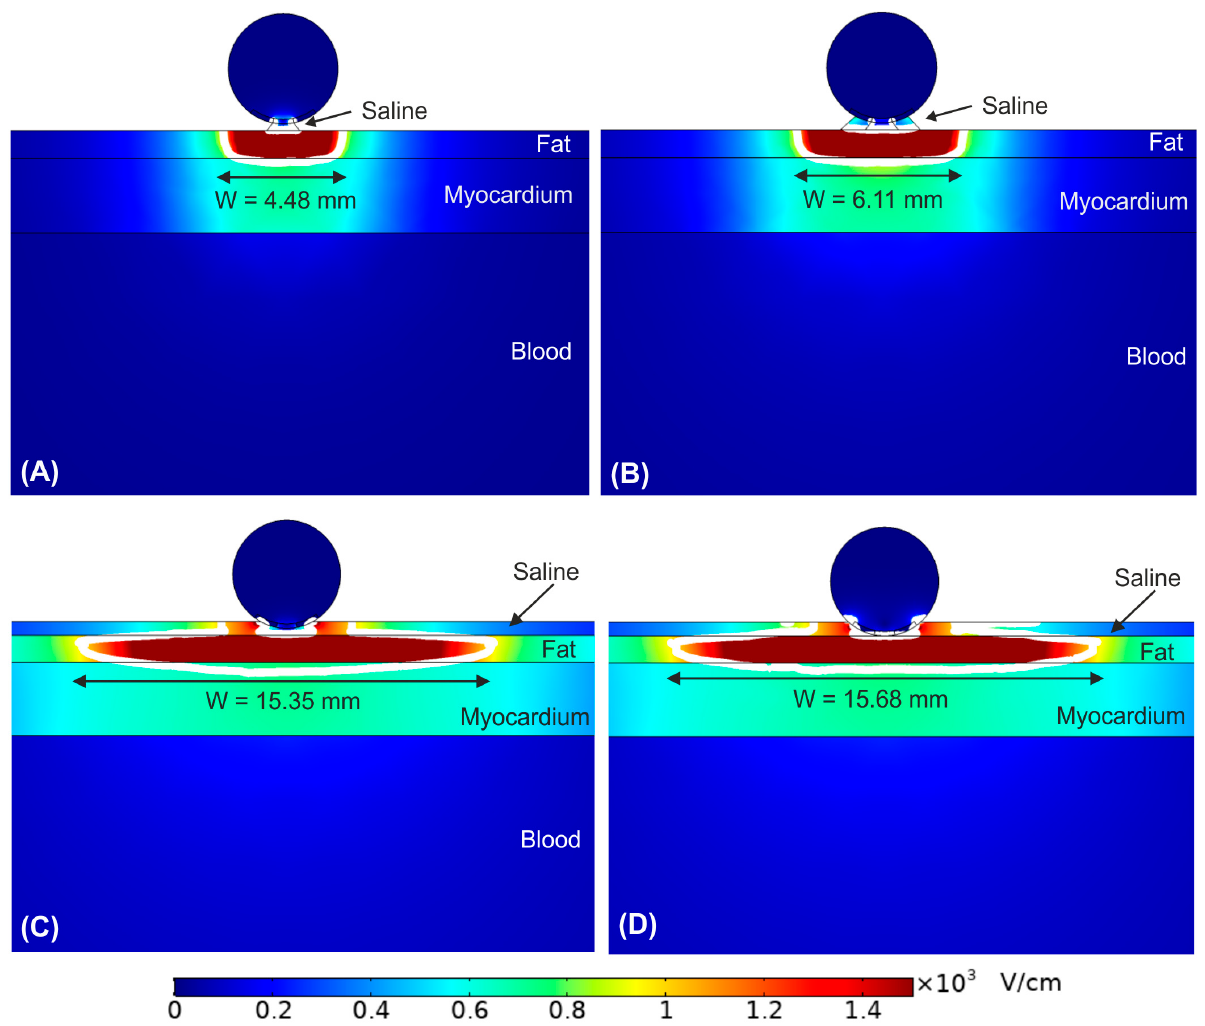
Figure 3. Electric field distribution around the target site (epicardium) to assess the effect of the extension of the saline on the epicardial fat. Different scenarios were compared: ( A ) the saline just below the irrigation hole, ( B ) the saline extends over the entire surface of the ablation device, ( C ) the saline extends over the entire surface of the epicardial fat with the ablation device embedded partially on it, and ( D ) the saline extends over the entire surface of the epicardial fat with the ablation device totally embedded in it. The white contour corresponds to the 1000 V/cm electric field isoline.